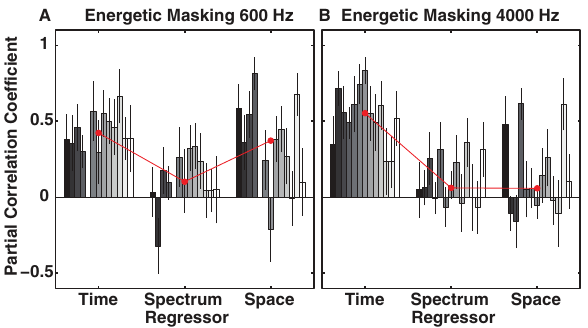
Figure 6. Partial correlation coefficients (weights) for regres- sors temporal onset (time), masker type, i.e. eC and eR (spectrum), and spatial separation between signal and masker (space) as obtained by multiple linear regression. Results for the 600-Hz and 4000-Hz signal with energetic maskers for individual subjects (bars in different shades of gray) are shown in A and B, respectively. Error bars indicate 95% CIs and the red line with circular markers depicts the median across all subjects. Values close to 1 (0) indicate a strong positive (weak) weight of a given regressor. Subject order as in Fig. 1.